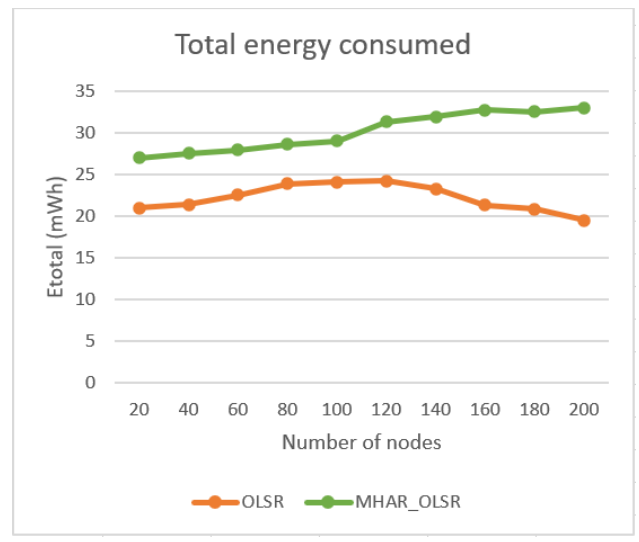
Figure 14. Total energy consumed as a function of